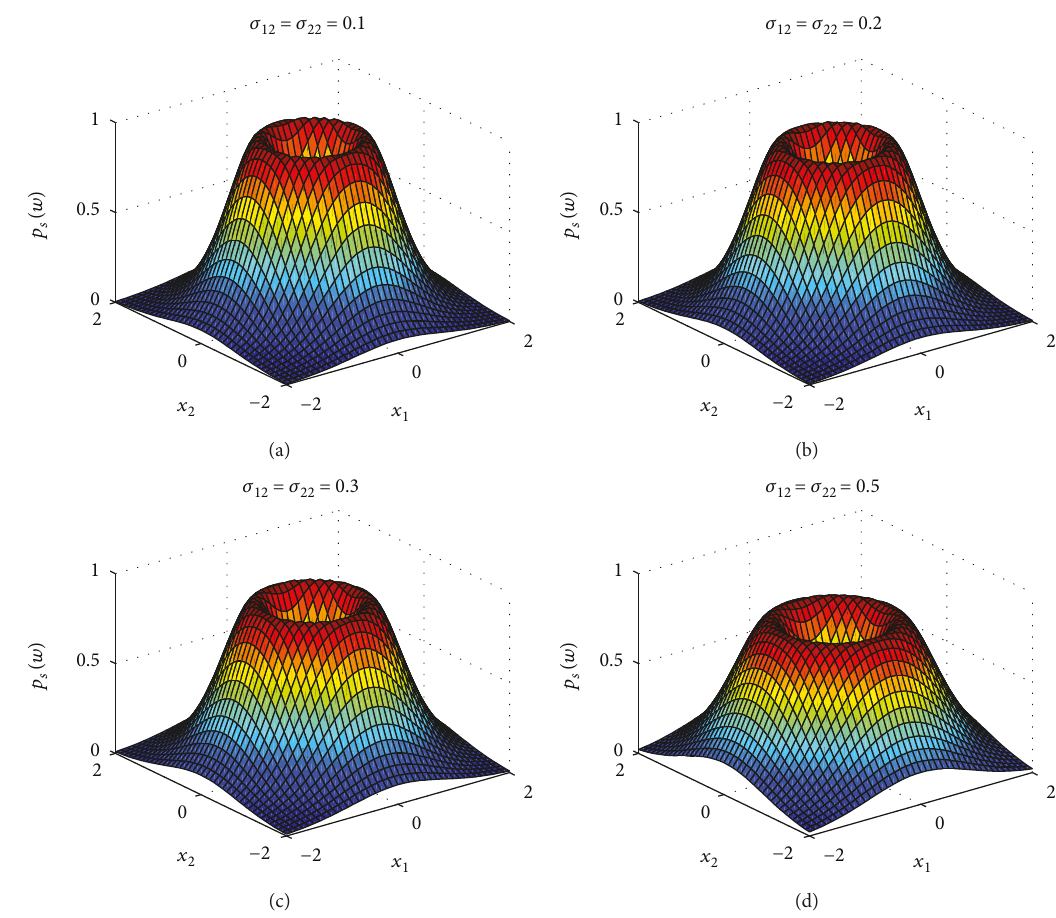
= 2 , b = 0 4 , a = 0 5 , k = 6 , q = 0 1 , m 1 1 1 ω corresponding to Figure 3 in the x s